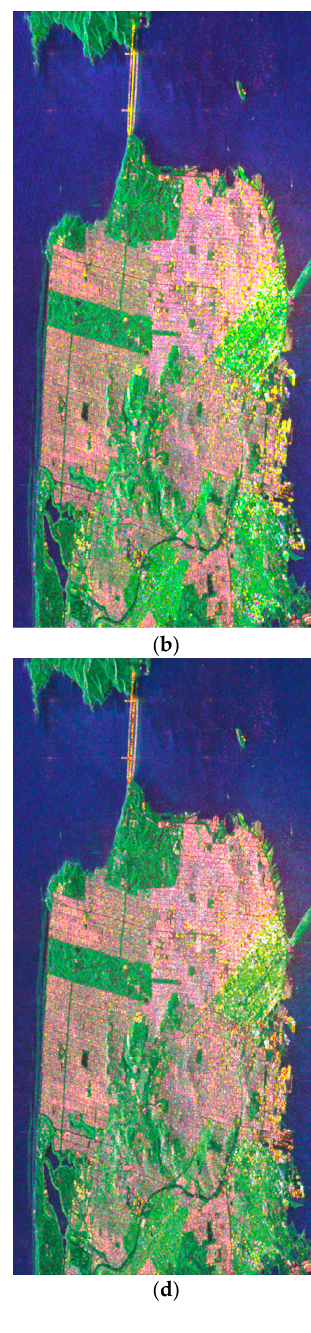
Figure 7. Decomposition results from Radarsat-2 data over San Francisco area. ( a ) Yamaguchi decomposition with orientation compensation; ( b ) Modified Chen decomposition by using modified parameter inversion algorithm; ( c ) Proposed GMD–GVSM decomposition; ( d ) Proposed GMD–SAVSM decomposition. The images are colored by Pd (red), Pv (green), Ps (blue).